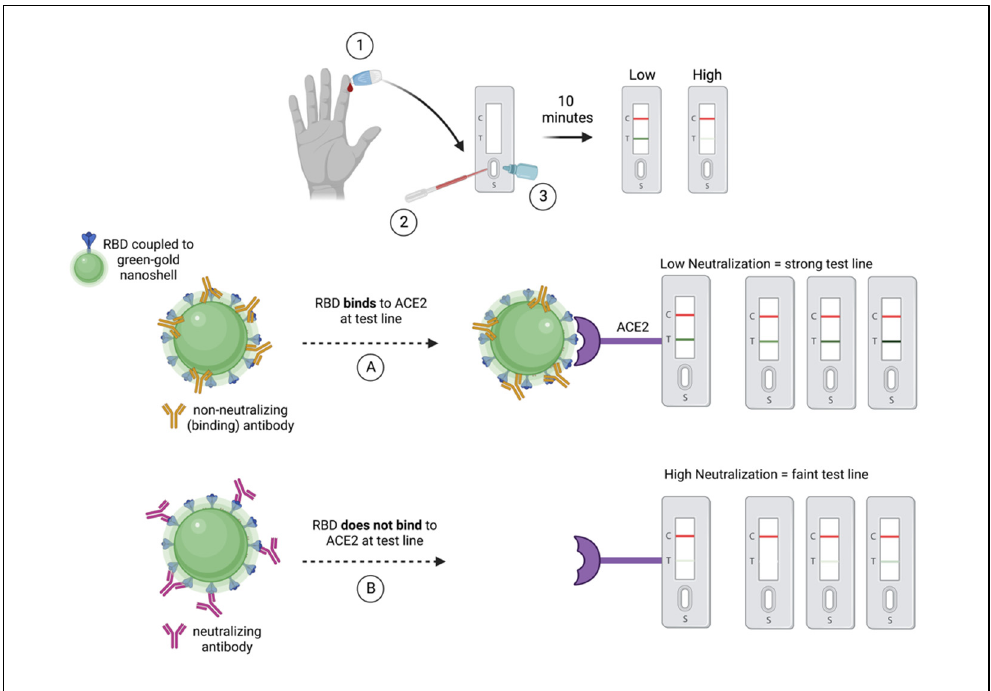
Figure 1. Schematic diagram of NAb LFA principle/mechanism. ( 1 ) Fingerstick blood is obtained using a pressure-activated safety lancet. ( 2 ) Ten microliters of blood are transferred to the sample port on a test cassette. ( 3 ) Buffer is applied to the sample port. (Left to right) RBD of spike (blue) is shown coupled to a green-gold nanoshell (green-GNS). Non-neutralizing antibodies (gold) are shown to bind outside of the RBD, such that in outcome ( A ) RBD-GNS is available to bind ACE2, seen as a strong test line. Neutralizing antibodies (maroon) are shown binding to RBD, obstructing the interaction between antigen and receptor, such that in outcome ( B ) RBD does not bind to ACE2, observed as a faint or absent test line.